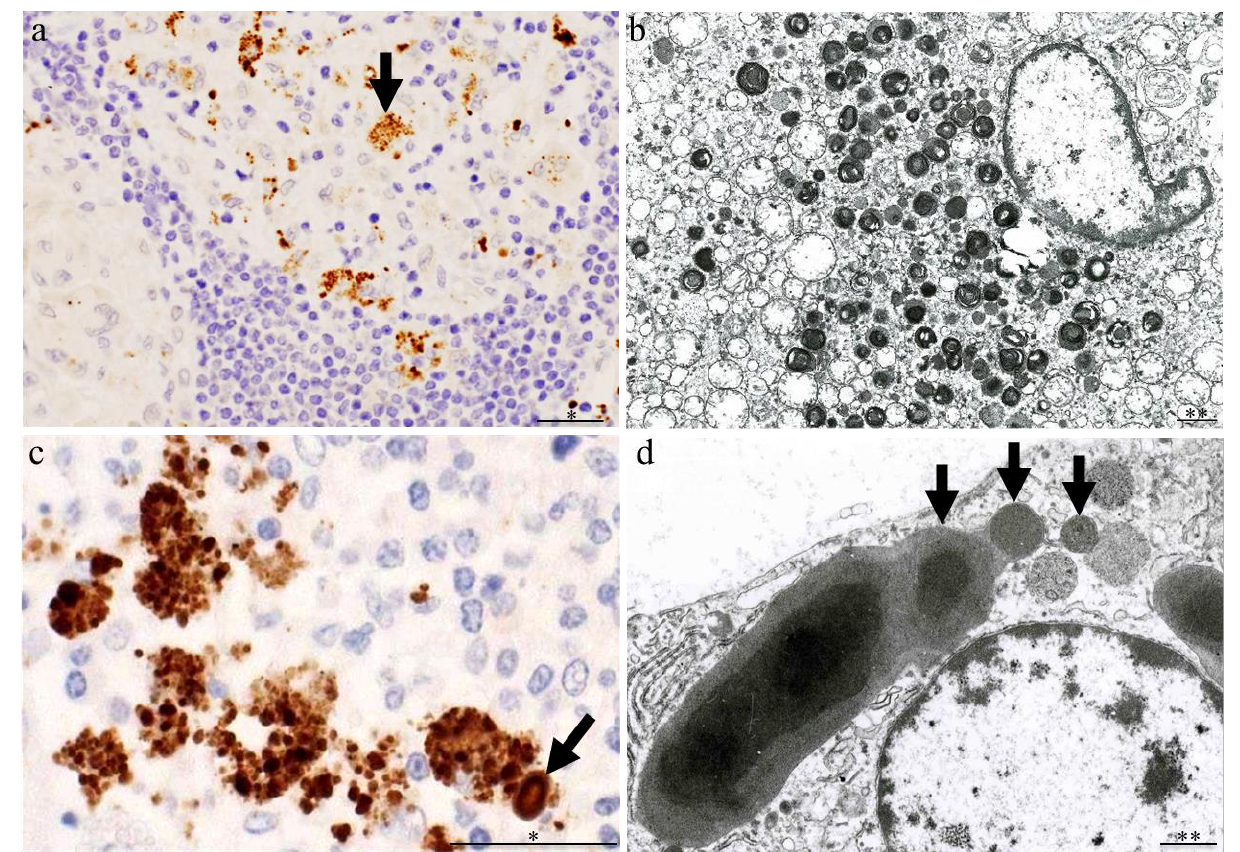
Figure 2. Features of intracellular C. acnes proliferation in sarcoid lymph nodes. Some granuloma cells (arrow) ( a ) are filled with PAB antibody-positive signals that are observed via electron microscopy as small round electron-dense bodies with a lamellar structure due to their partial deterioration ( b ). A cluster of swollen macrophages filled with many PAB-antibody-reactive small round bodies with a similar PAB antibody-reactive HW body (arrow) ( c ) can be observed at the paracortical area adjacent to granulomas. Small round bodies (arrows) ( d ) extruding from the large ovoid HW body can be observed in macrophages. All photos are original and were previously published [35]. Scale bar: * 50 μm, ** 1 μm.